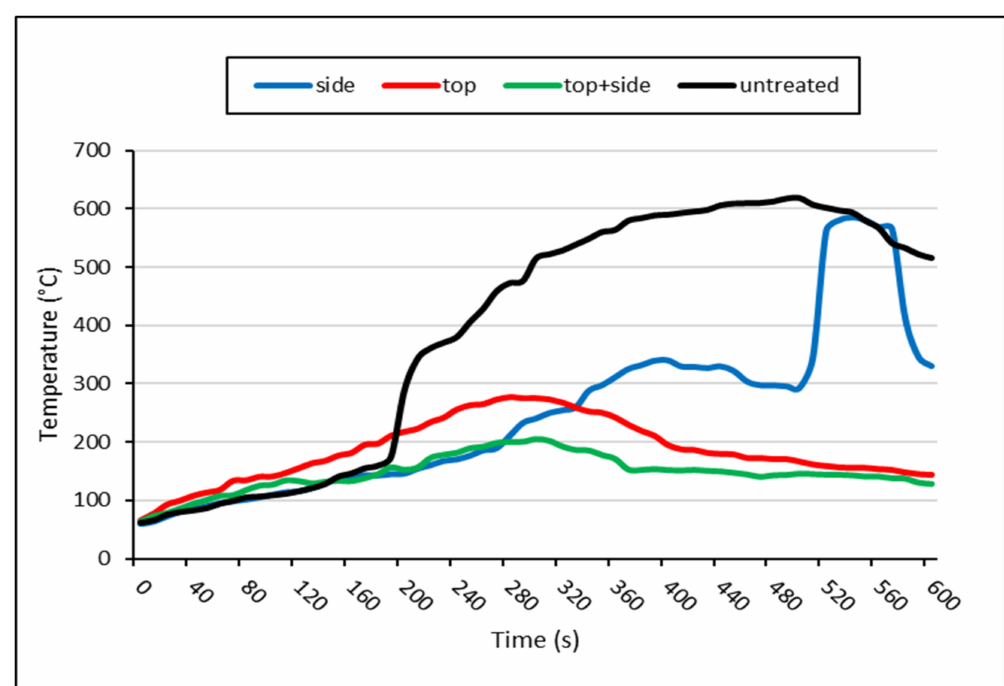
Figure 5. Temperature course of the samples on side B.